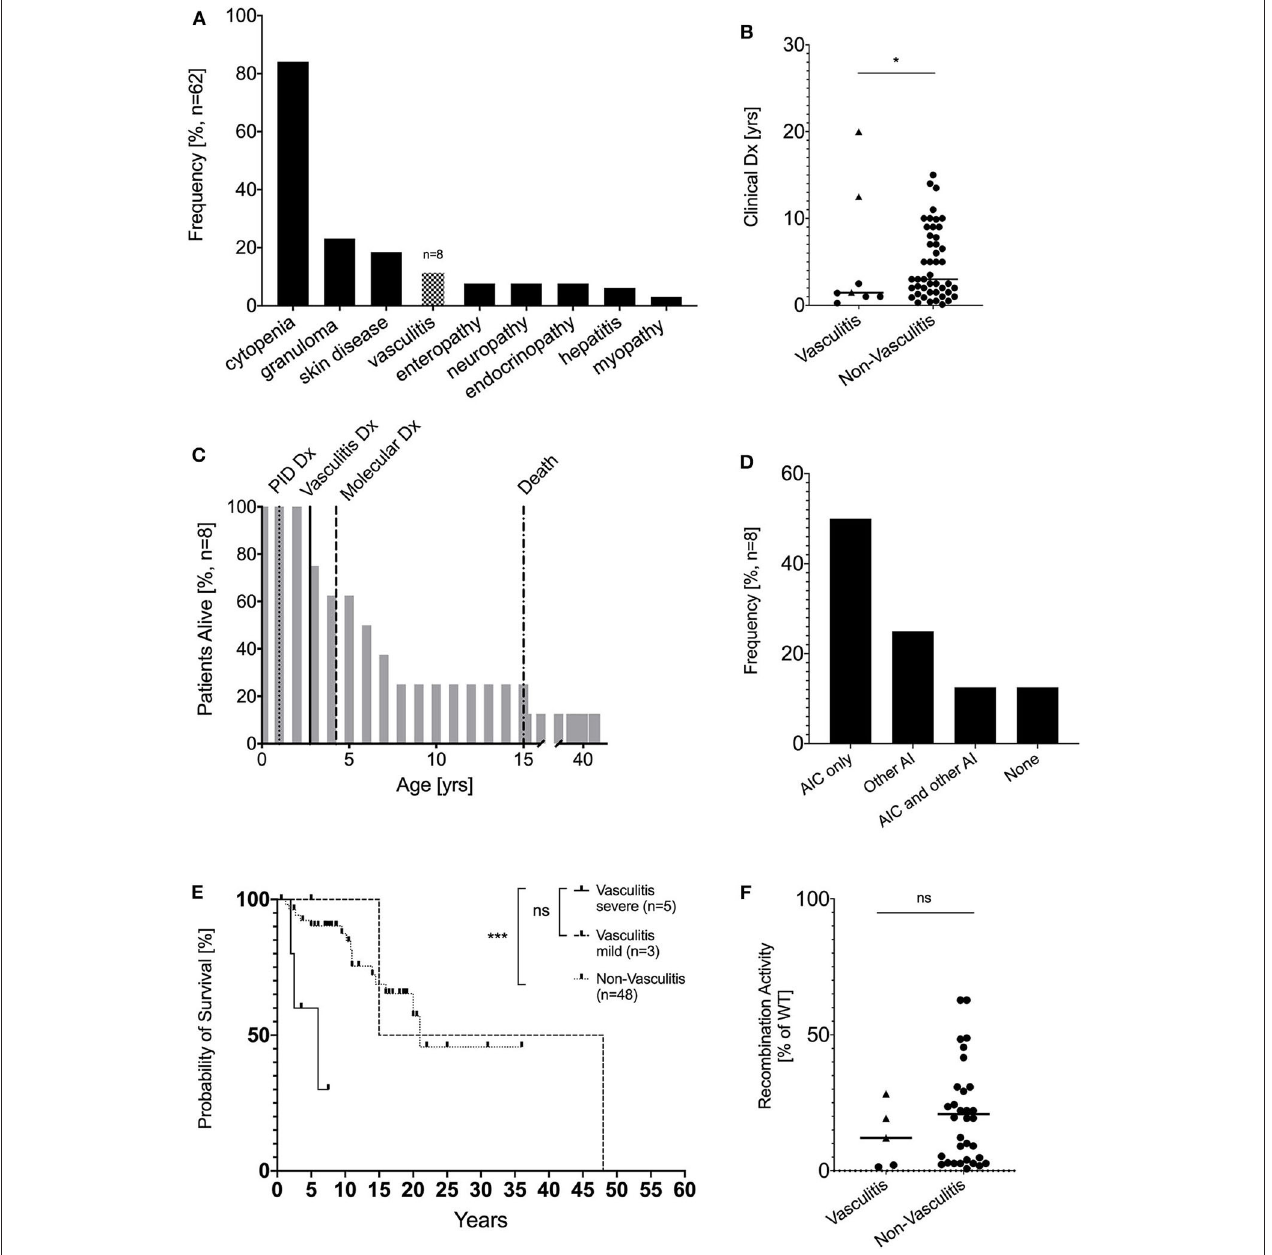
FIGURE 1 | Demographic and clinical characterization patients with vasculitis due to RAG deficiency. (A) Vasculitis is the fourth most common complication of pRD with immune dysregulation in a cohort of 62 patients (modified from 13) (B) Clinical diagnosis of PID in years compared between patients with pRD ( n = 8, circles = severe/multiorgan, rectangle = mild/skin-only) or without ( n = 54) vasculitis and RAG deficiency (* p < 0.05) (C) Percent of patients alive by age and annotate clinical milestones (D) Kaplan-Meier curves comparing survival of RAG-deficient patients with ( n = 8, dotted line) and without ( n = 54, straight line) vasculitis (E) Overall frequency of autoimmune complications besides vasculitis in adult patients with RAG deficiency, AIC… autoimmune cytopenia, AI… autoimmunity (F) Recombination activity from all available RAG1/2 alleles (average of % wild-type protein). For the non-vasculitis control group only patients with CID-G/AI and AS phenotype were considered. (circles = severe/multiorgan, rectangle = mild/skin-only) (ns statistically not significant, * p ≤ 0.05, *** p ≤ 0.001).